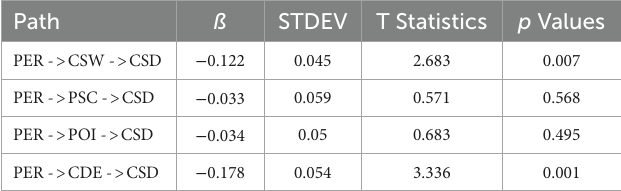
TABLE 2 Discriminant validity.